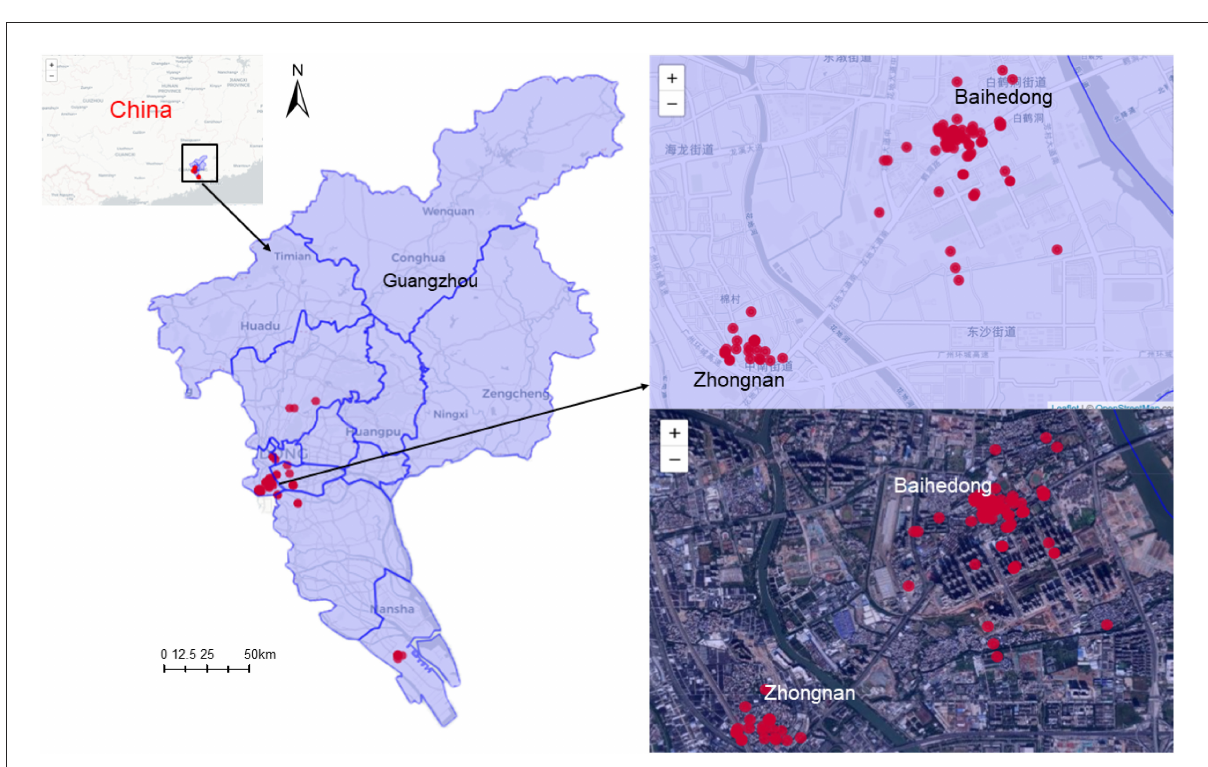
FIGURE2 Spatial distribution of SARS-CoV-2 Delta VOC outbreak in Guangzhou, from May 21, 2021 to June 18, 2021.